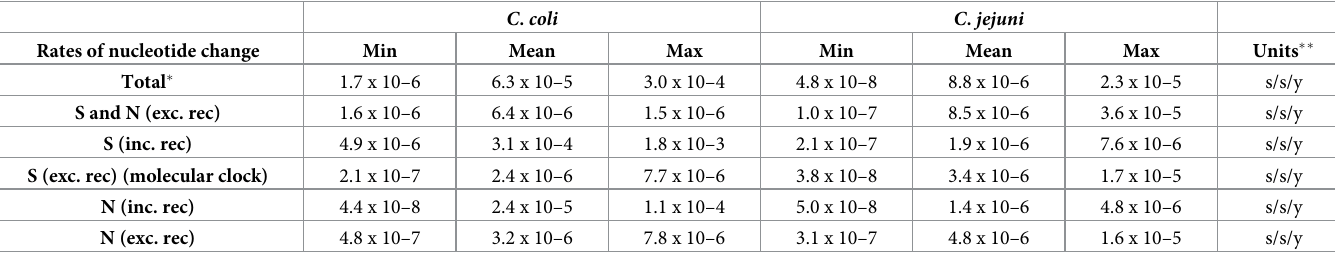
Table 1. Average rate calibrations for C . coli and C . jejuni .